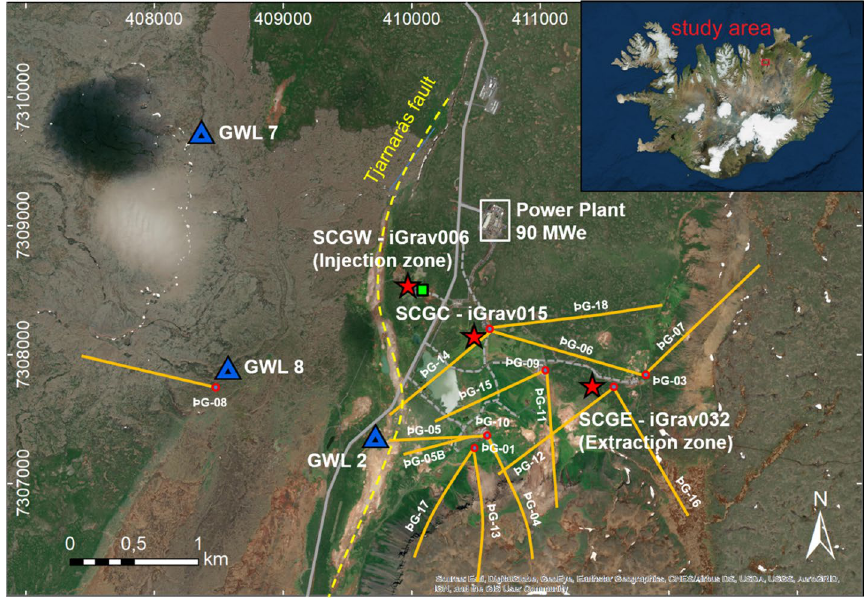
Fig. 1 Location of the three continuous gravity stations (red stars) at Þeistareykir geothermal field in North Iceland; the east station (SCGE, iGrav032) is positioned in the vicinity of the geothermal extraction wells (well pads marked by red circles, orange lines show subsurface well paths), the west station (SCGW, iGrav006) is positioned in the vicinity of the reinjection well pad (green square) close to the Tjarnarás fault (yellow dashed line), the central station (SCGC, iGrav015) is positioned between the extraction and injection zones; groundwater level monitoring wells (GWL, blue